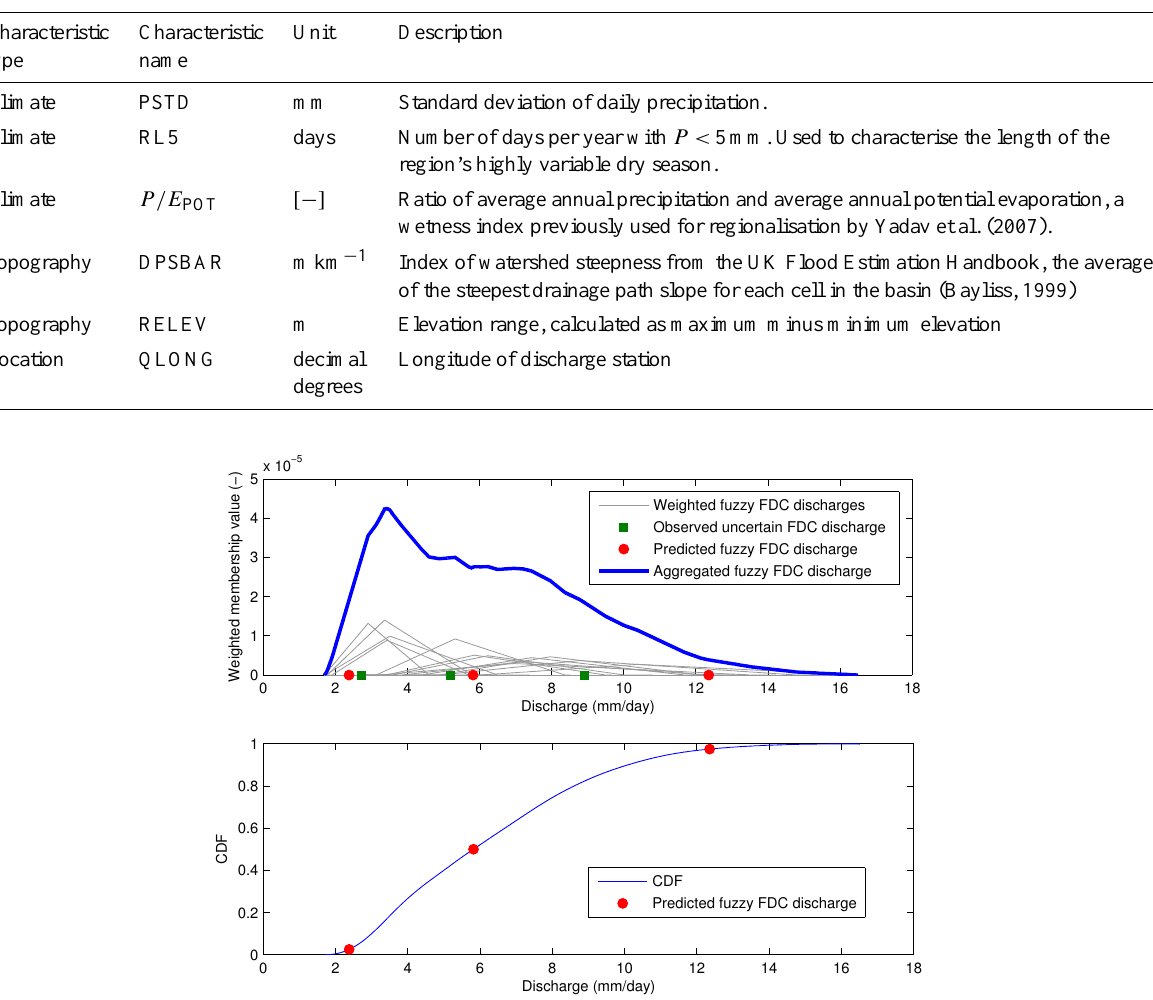
Table 1. Basin and climate characteristics. Climate indices calculated for 1965–1994.